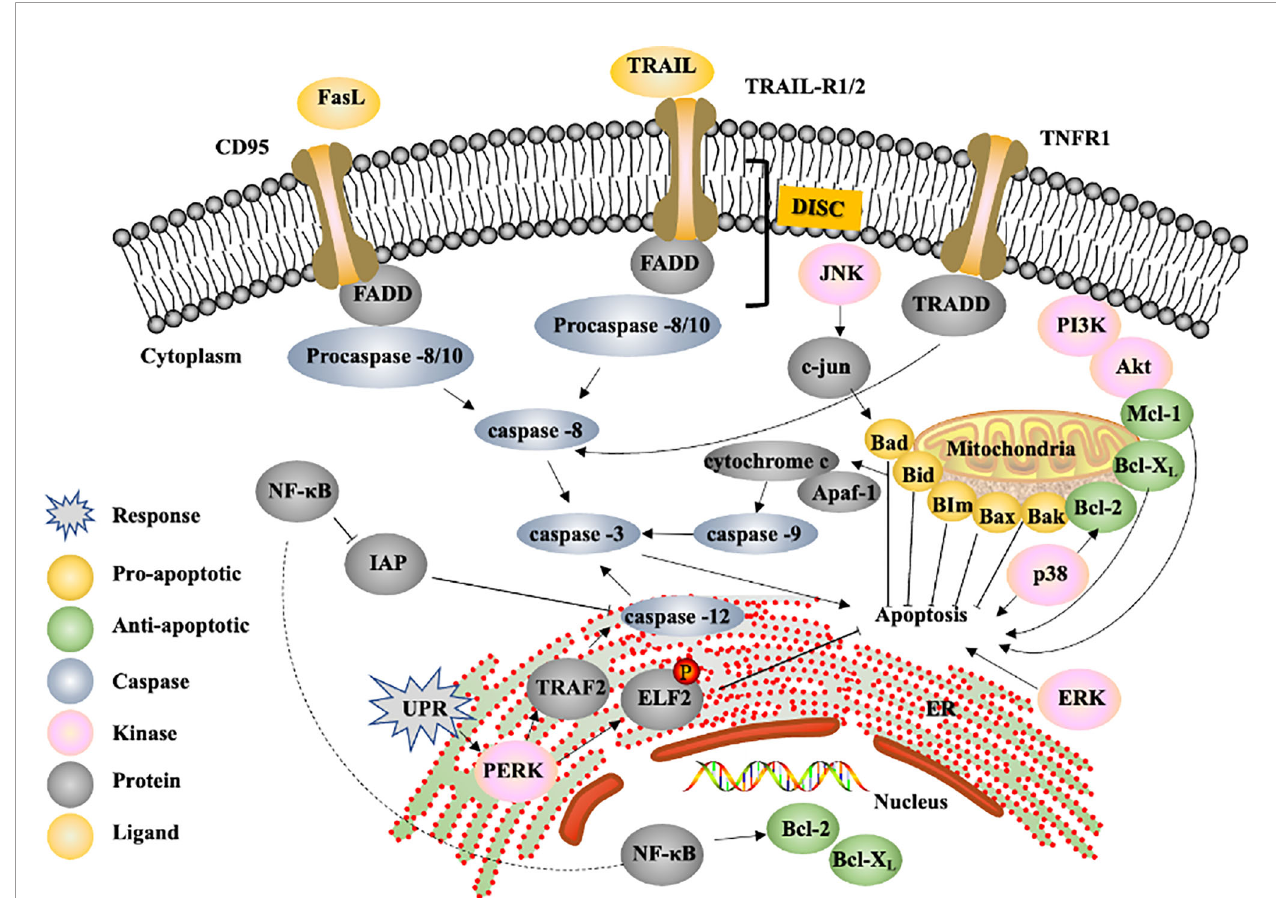
FIGURE 3 | Proposed signalling pathway by which natural compounds induce apoptosis and example of targets of apoptosis in tumor cells for liver cancer drug development. FasL, Fas ligand; FADD, Fas-associated protein with death domain; TNFR1, tumor necrosis factor receptor 1; TRADD, TNFR1-associated via death domain; DISC, death-induced signalling complex; IAP, inhibitor of apoptosis protein; UPR, unfolded protein response; ER, endoplasmic reticulum; PERK, double- stranded RNA-activated protein kinase-like ER kinase; TRAF2, TNF receptor-associated factor 2; ELF2, eukaryotic initiation factor